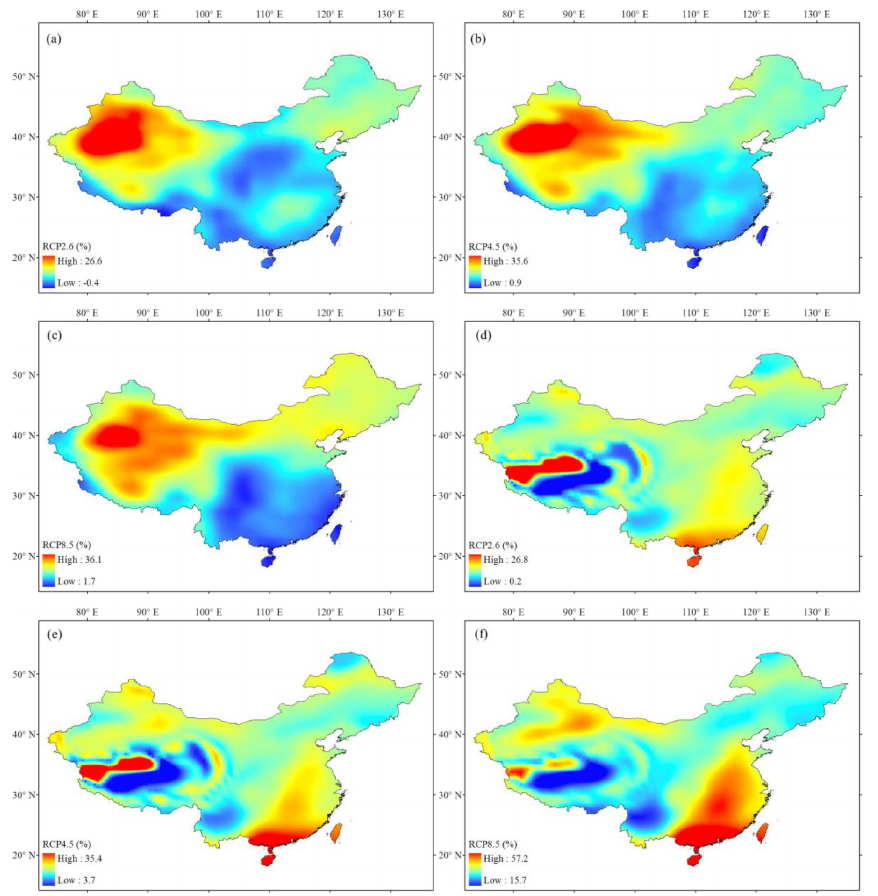
Figure 10. The CMIP5 multi-model ensemble median relative change (%) in mean annual P under (a) RCP2.6, (b) RCP4.5, and (c) RCP8.5 scenarios and in mean annual PET under (d) RCP2.6, (e) RCP4.5, and (f) RCP8.5 scenarios in China for the period 2071–2100 (relative to the baseline